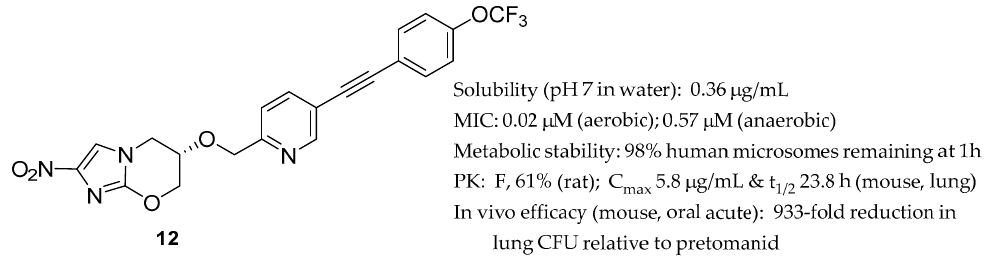
Figure 7. Profile of potential development compound 12 .